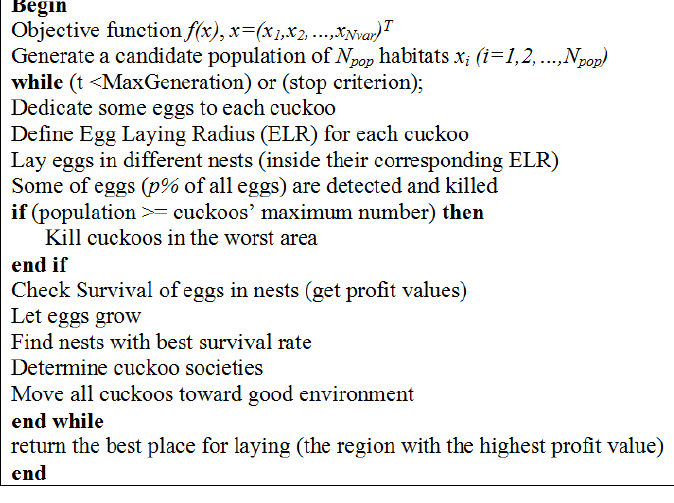
Figure 2. Pseudo code of the Cuckoo Optimization Algorithm (COA).